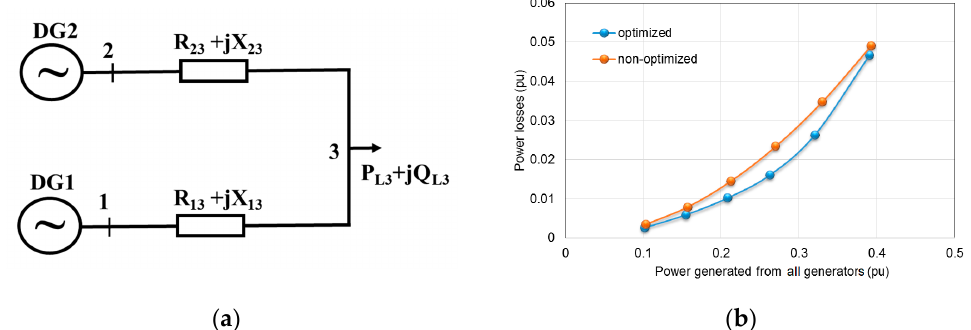
Figure 5. 3-bus system. ( a ) layout of the test system; ( b ) results of the optimization.